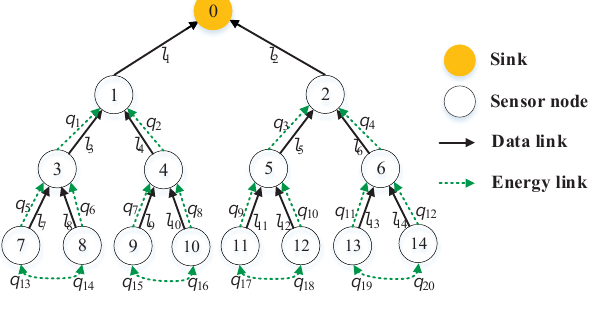
Figure 2. Data and energy topologies.